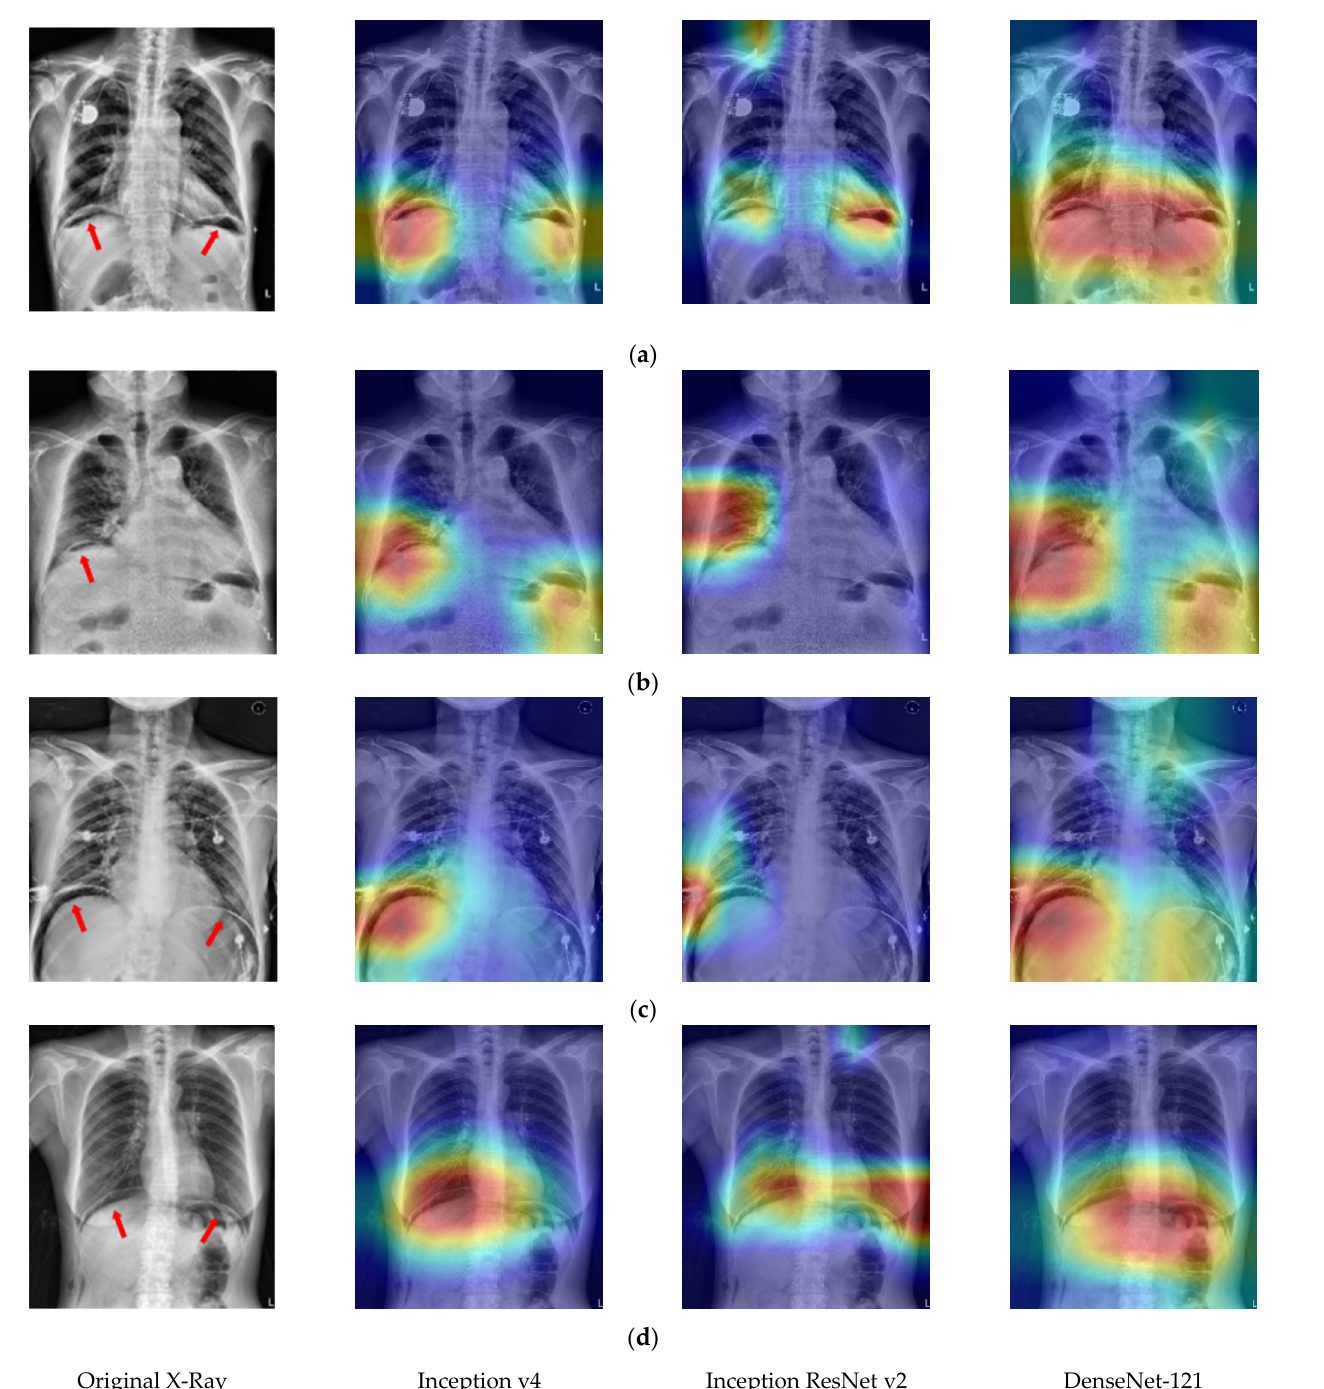
Figure 8. The heat map results of using three different CNNs on four selected TP cases ( a – d ). The red arrows in the first column indicate the lesion. The red areas in the 2nd to 4th columns are the regions where the CNN predicted them as positive cases.